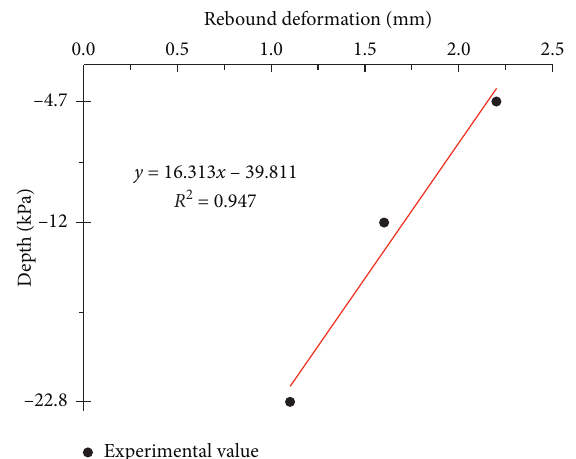
Figure 16: Curve of rebound deformation in the test with depth.